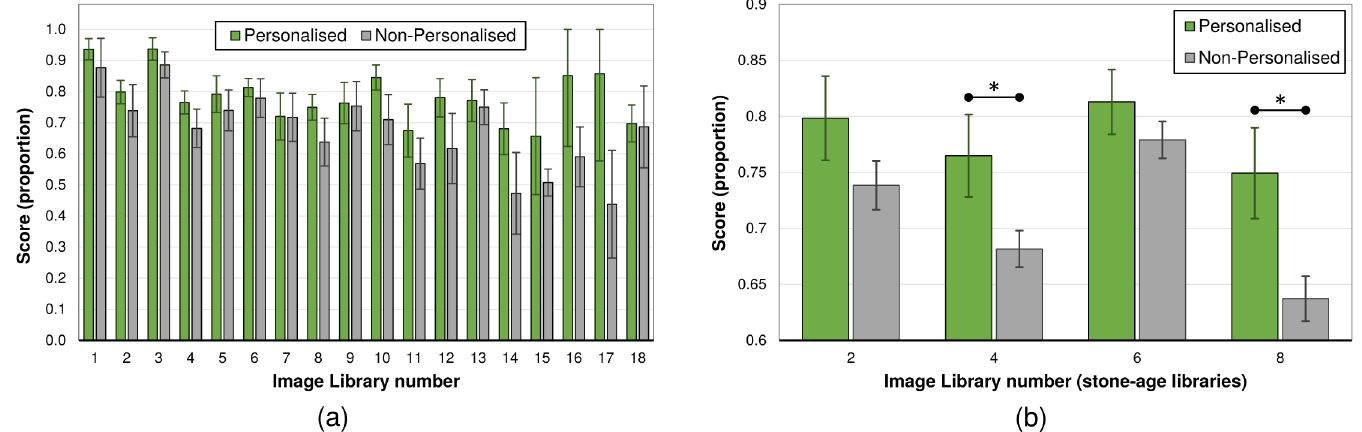
Fig 3. Library scores per image library. Overview of mean scores per library, by condition,error bars are 95% CI: (a) performancein each of the image libraries,see Table 1 for library contents; (b) scores for the first four stone-age image libraries(novel subject): ‘ * ’ denotessignificanceat the .05 level.